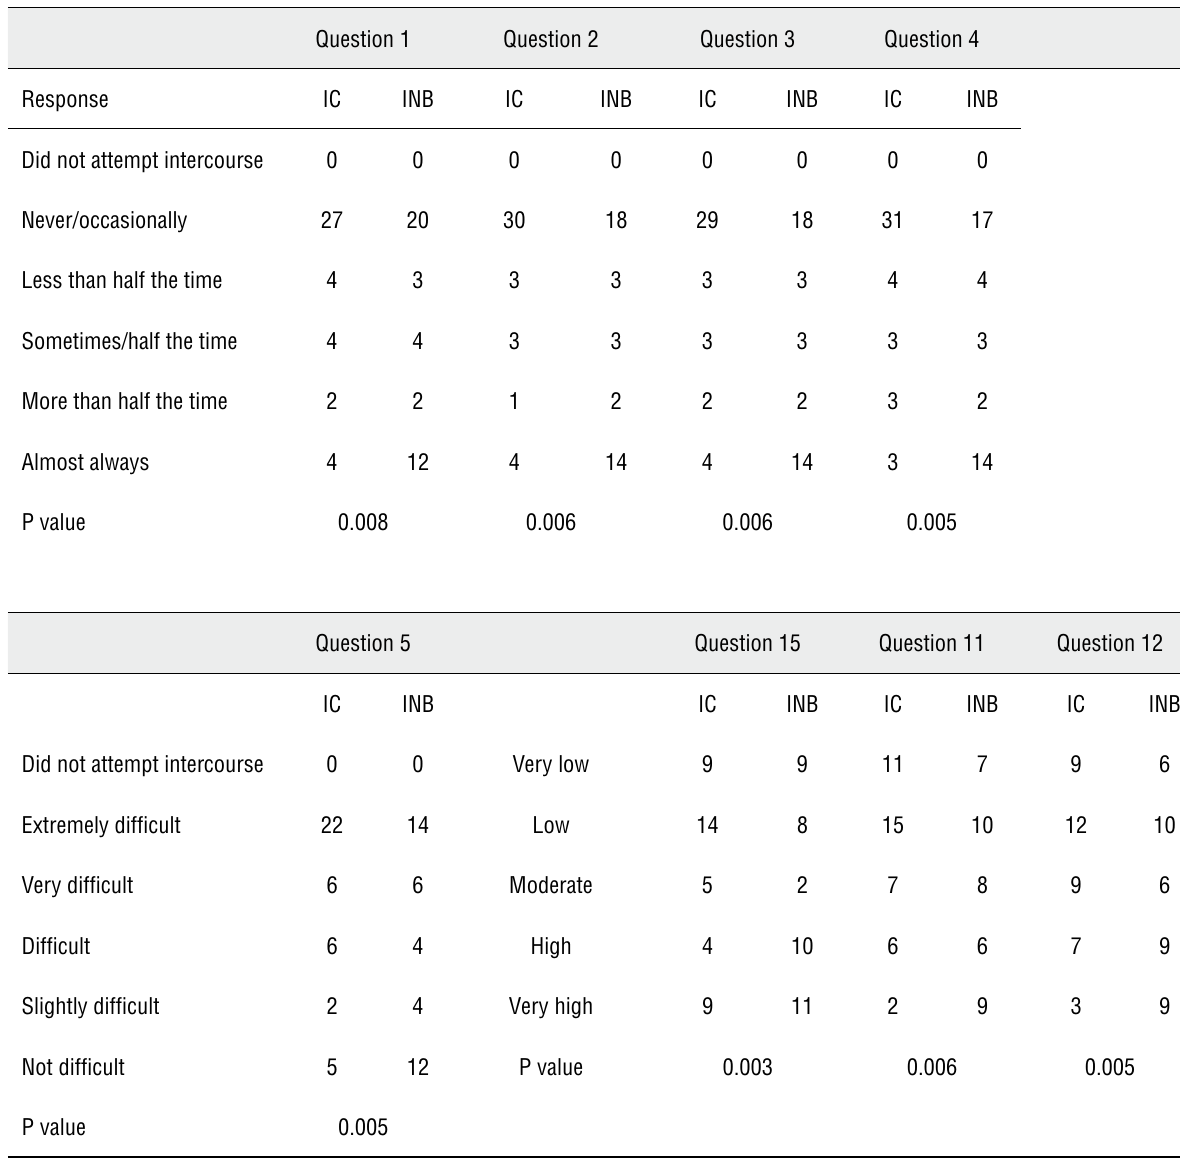
Table 4 - Responses to erectile function and sexual desire domains questions from IIEF questionnaire after radical cysto- prostatectomy at 12-month